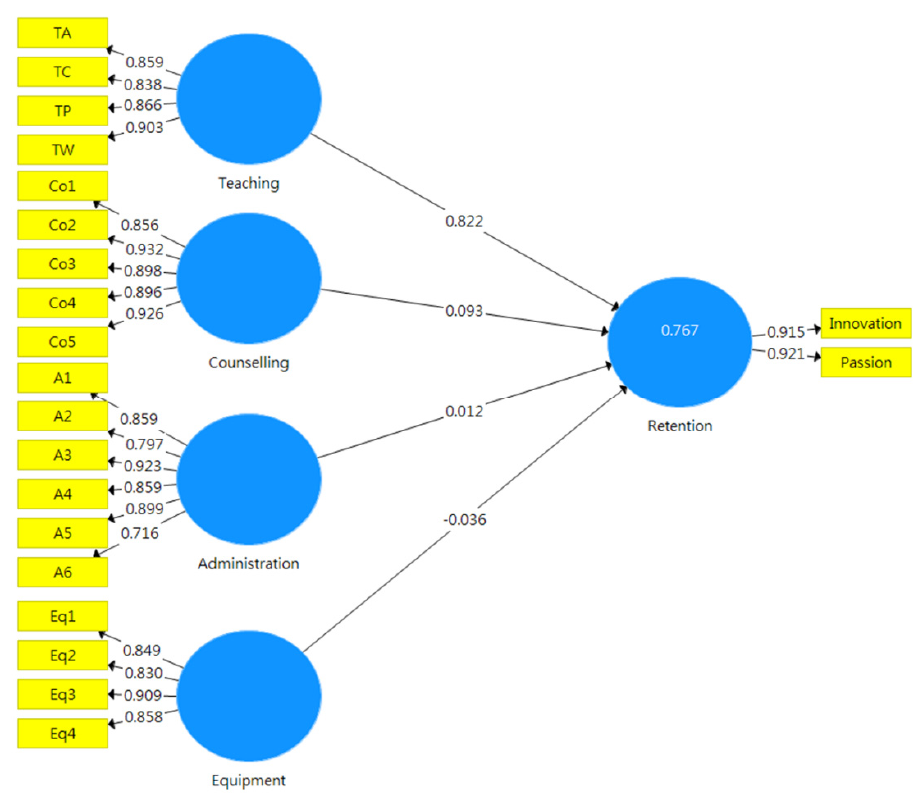
Figure 2. P artial least squares structure model (inner path coefficients and outer weights). Figure 2. Partial least squares structure model (inner path coe ffi cients and outer